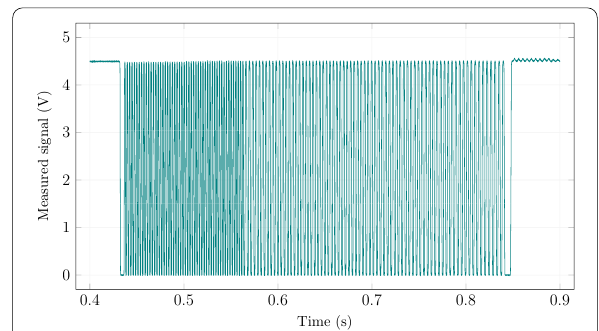
Fig. 6 An example of data acquired from one optical gate pair of the impactor’s measuring device.